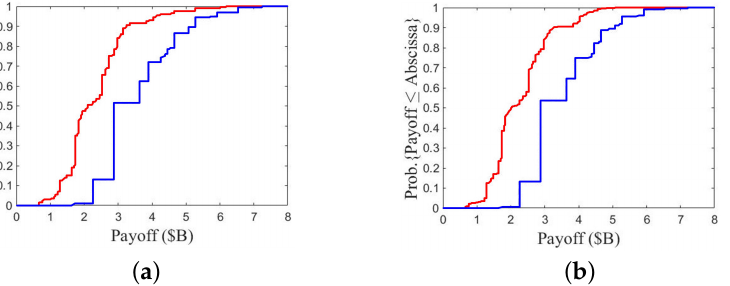
Figure 6. (A2/B3) Cumulative distribution of payoff with two P 2 SO runs, ( a ) over 200 games, ( b ) over 400 games; ———: fleet A, ———: fleet